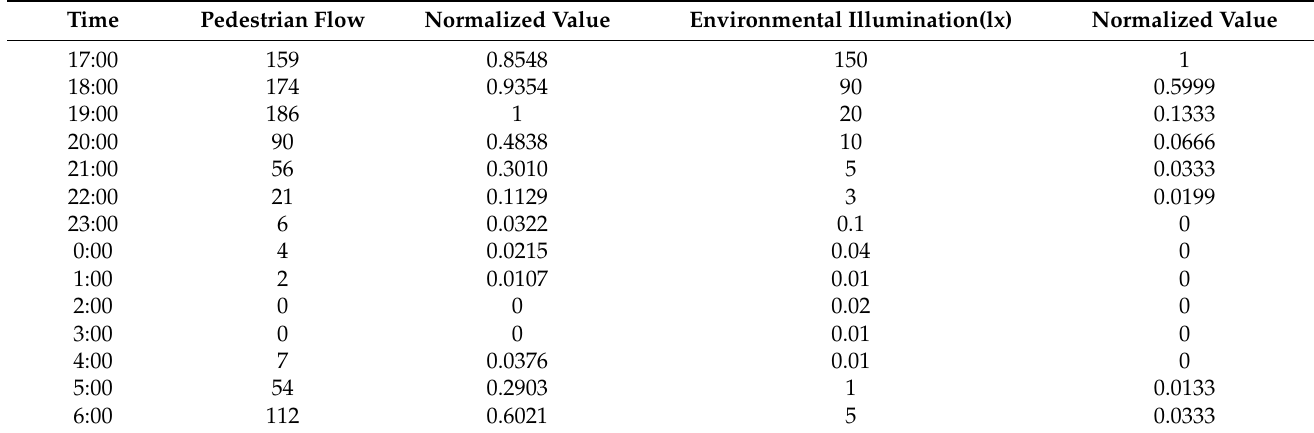
Table 3. Pedestrian flow and ambient light level data by time period.